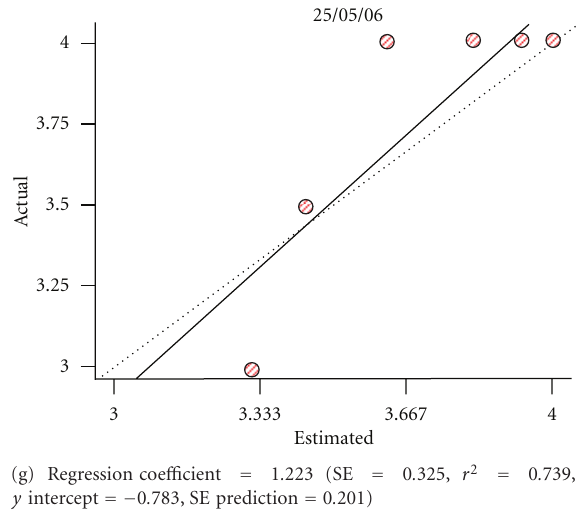
Figure 5: Cross-validation analyses (variograms) obtained for year